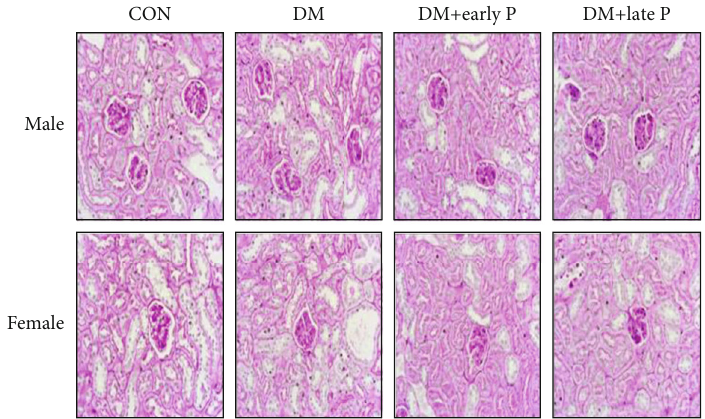
Figure 3: PAS staining of kidney sections. Representative PAS staining of kidney sections shows normal morphology of glomerulus and PCT in the control group. DM mice exhibited extended tubules, while early and late paricalcitol treatments restored the extended tubule shape to normal. Magni fi cation, ×